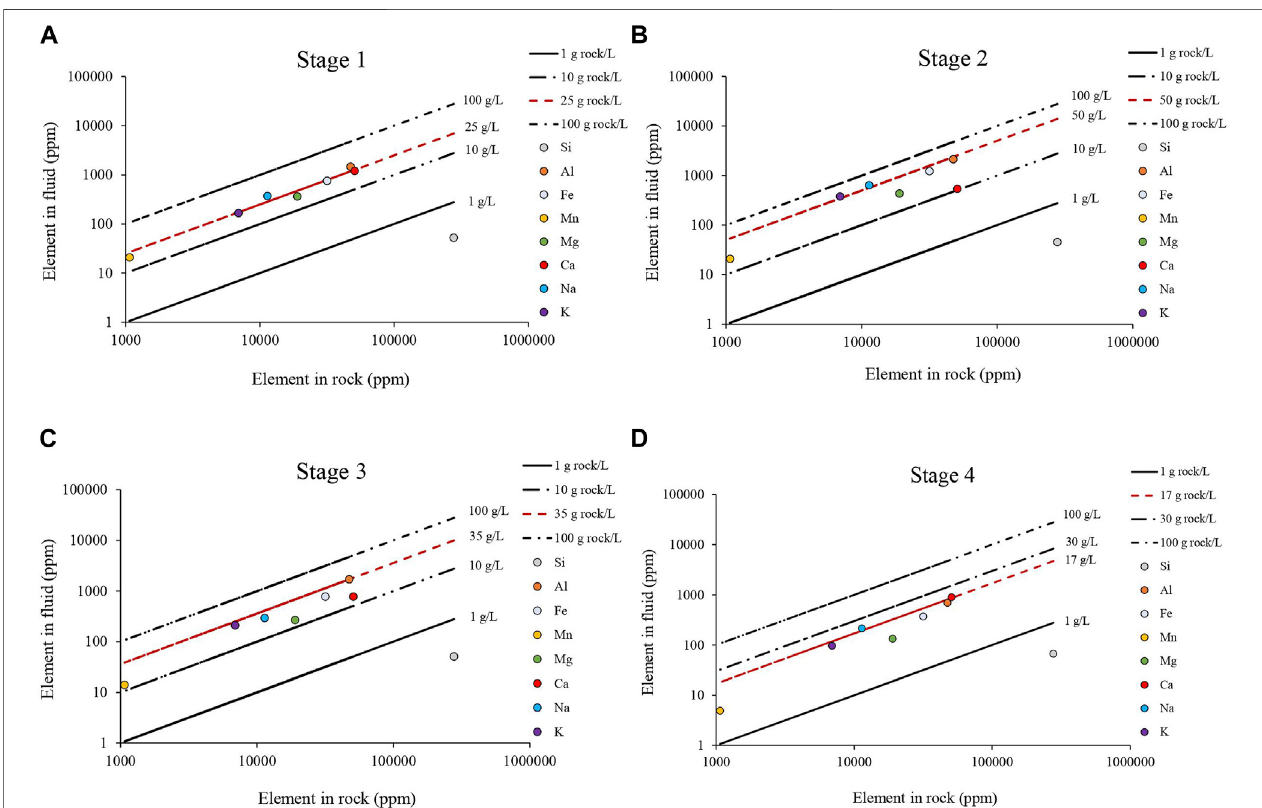
FIGURE10| Isosolplotsshowthattheamountofrockdissolvedperliteroflakewaterandthelossofelementsinwater,especiallyCaloss,isconsideredtheeffect of the gypsum/anhydrite precipitation. The four isosol plots are representative of the dissolution of the rock and the Ca loss during (A) stage 1, (B) stage 2, (C) stage 3, and (D) stage